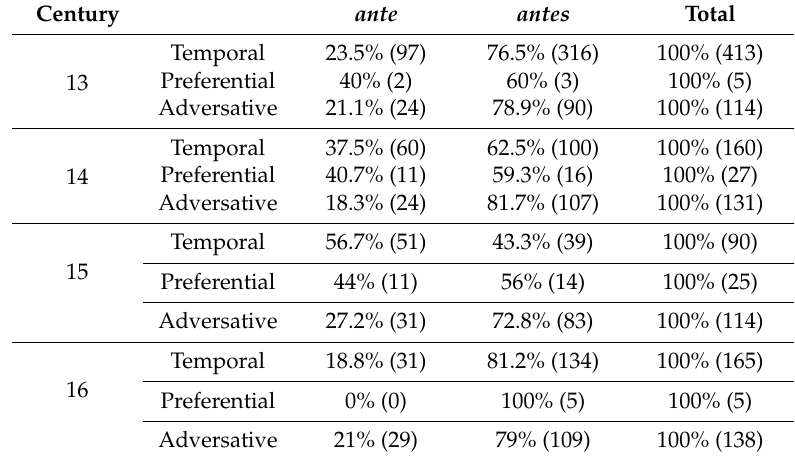
Table 5. Frequencies of ante and antes per meaning (temporal, preferential, adversative) and per